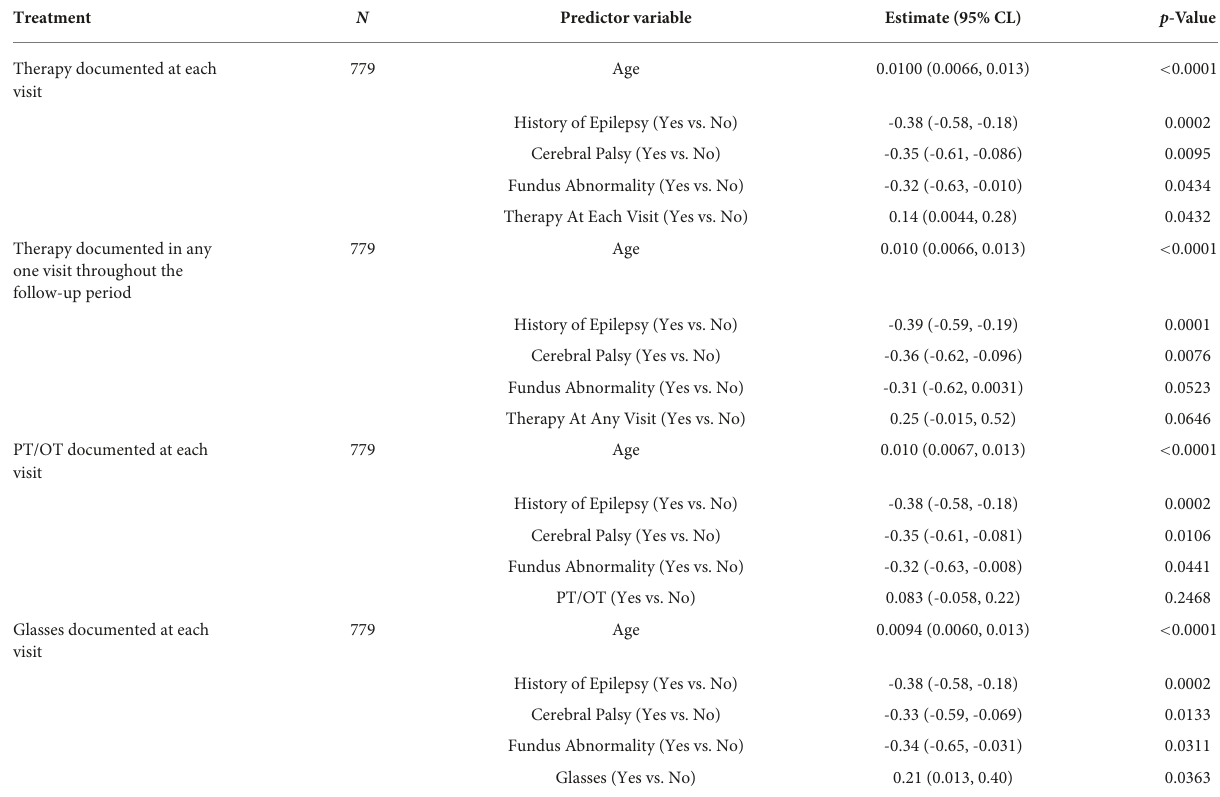
TABLE 5 Treatment effect on Longitudinal CVI grade outcome using mixed-effect